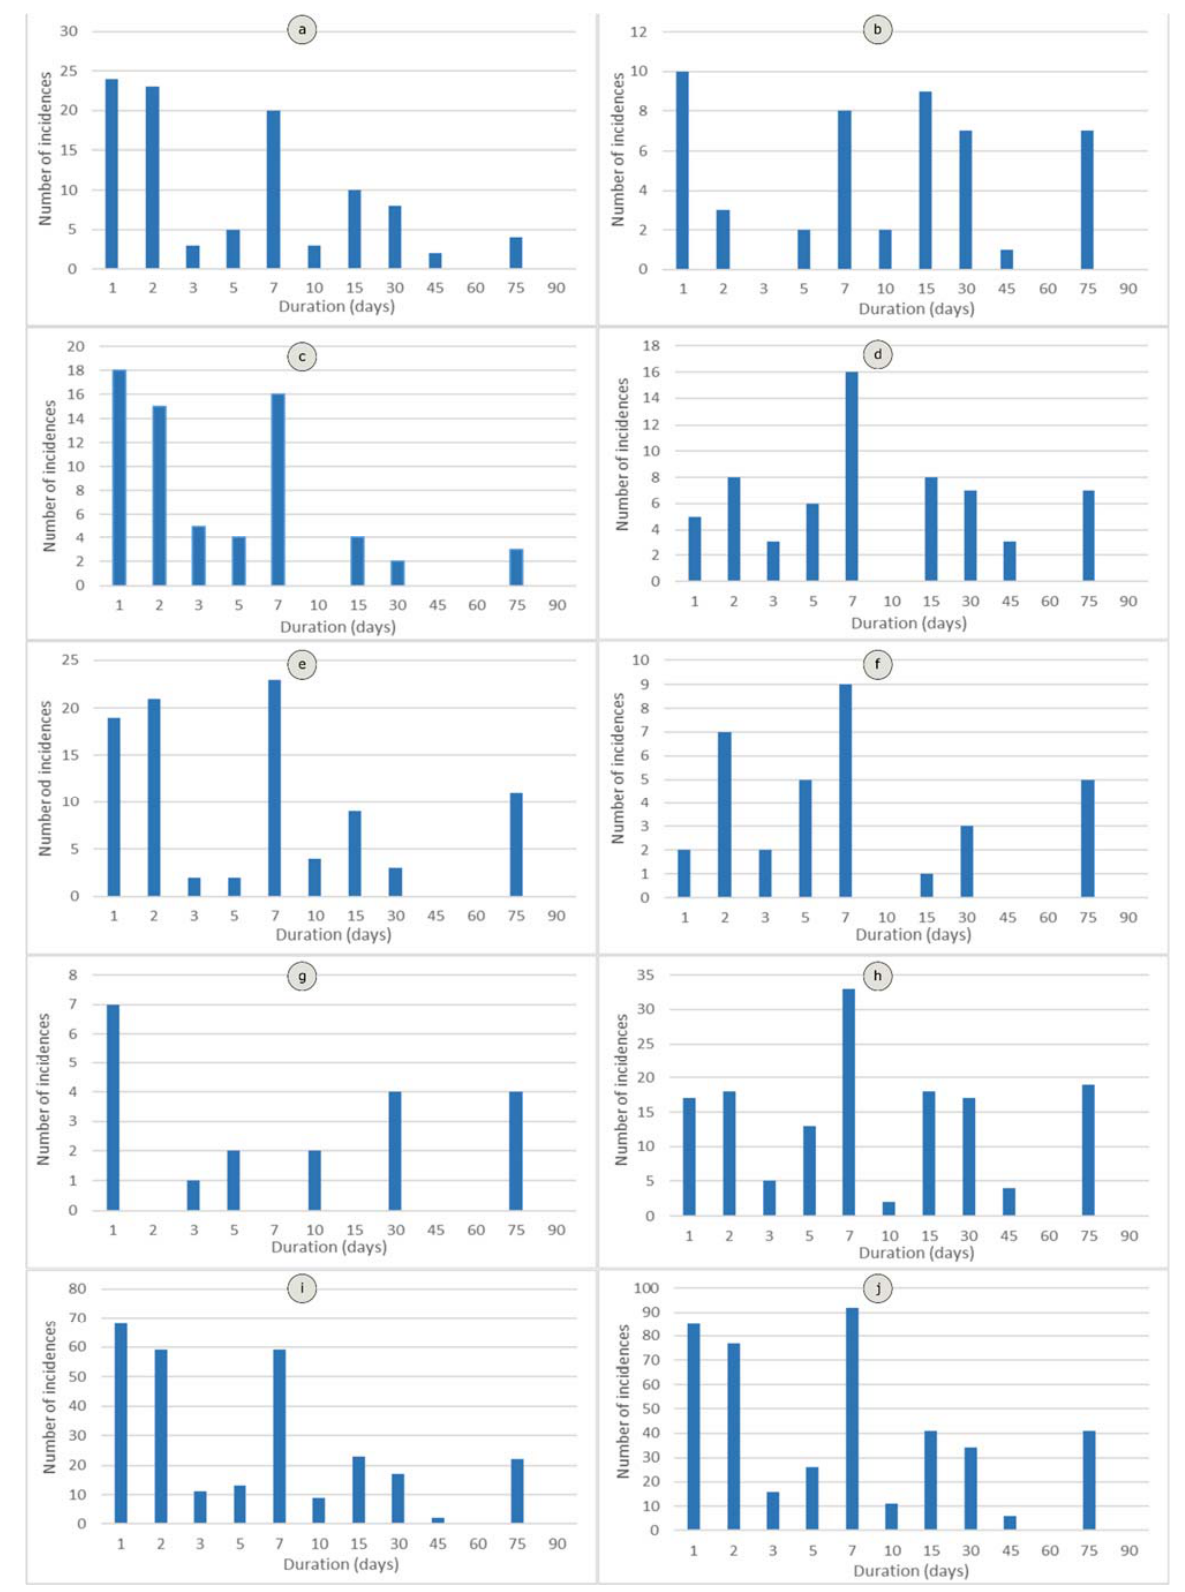
Figure 7. Duration of rainfall event for incidences of the different typologies ( a ): Gullies; ( c ): undercut in road embankments; ( e ): slides in road cuts; ( g ): collapses; ( i ): total of lower magnitude (very shallow) incidences; ( b ): slides; ( d ): flows; ( f ): creep; ( h ): total of higher magnitude (shallow) incidences; and ( j ) all incidences.